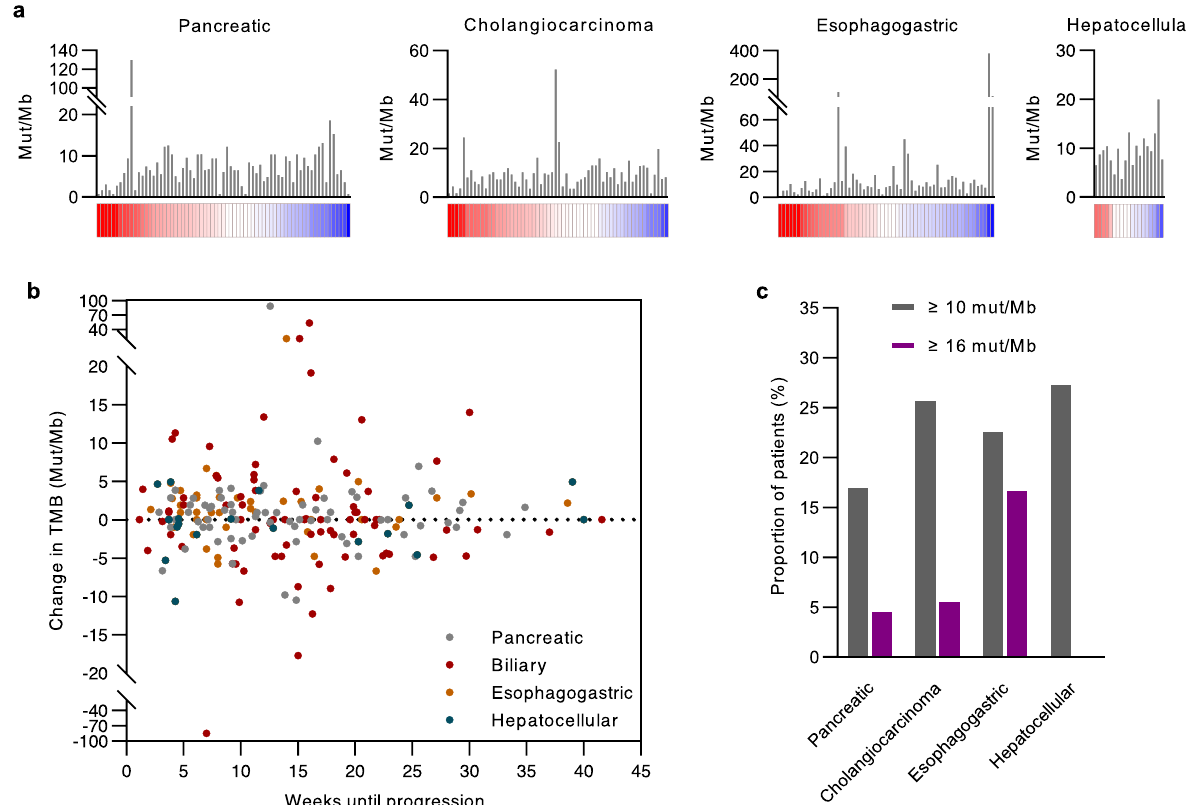
Fig. 3 | Evolution of tumor mutation burden. a Column charts depict baseline TMBvaluesonthey-axiswithpatientsonthe x axisrankedbythepercentchangein TMB atprogression. Patients withthe greatest changesinTMB are in the farleftof each column chart. Heatmaps along the x axis depict relative changes in TMB at progressioncalculatedastheprecentofTMBatbaseline,withredindicatingvalues